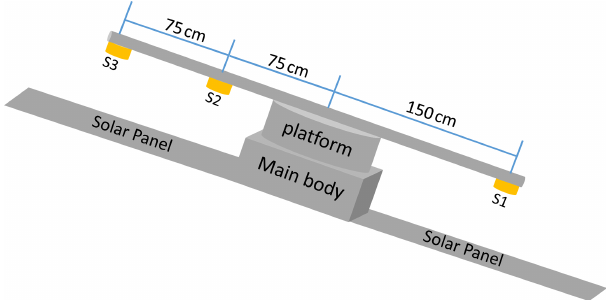
Figure 1. Schematic diagram of the installation positions of the three magnetometer sensors on board the